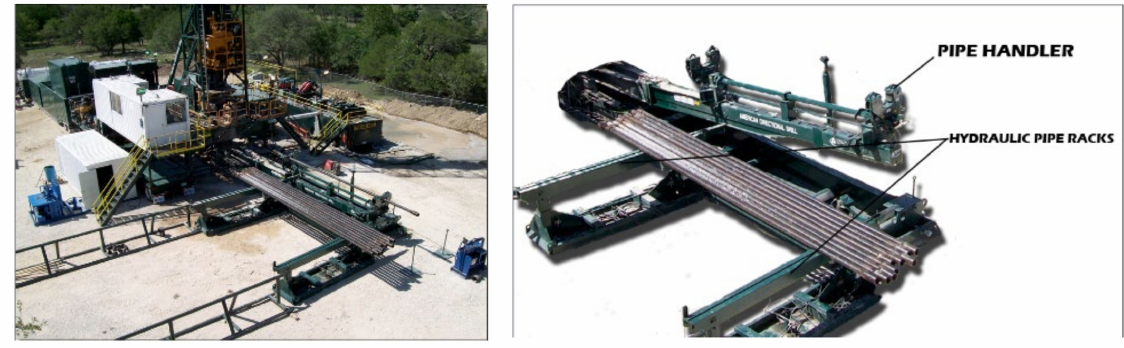
Figure 1. Pipe-handling system for HWD lifting arm type.